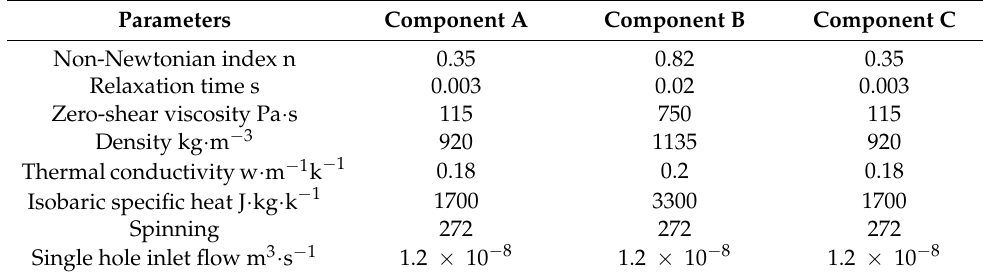
Table 1. PA6 and PP material parameters and spinning process